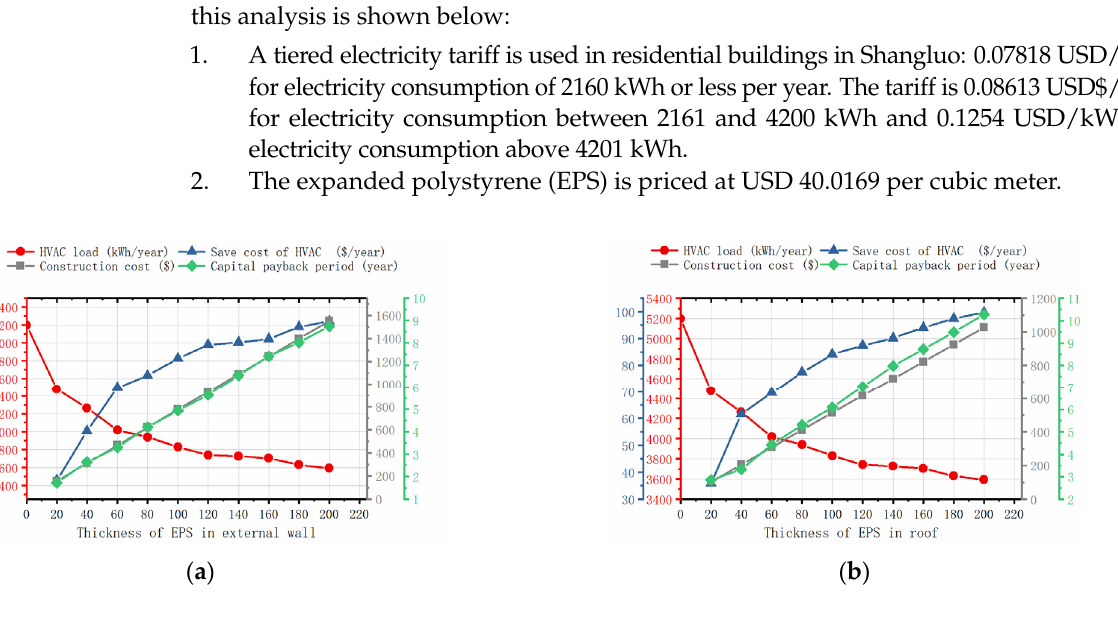
Figure 9. ( a ) The payback period of capital for different thicknesses of EPS in external walls; ( b ) The payback period of capital for different thicknesses of EPS in the roof.